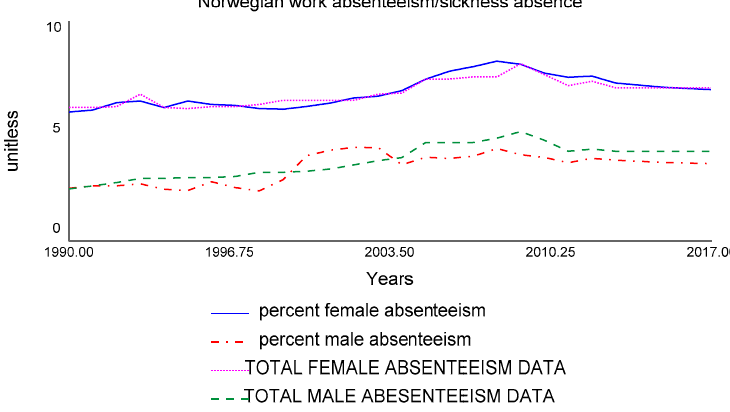
Figure 1. Reference mode and simulated behavior of male (green-data, red-simulation) and female (pink-data, blue-simulation) work absenteeism rates (in percent).